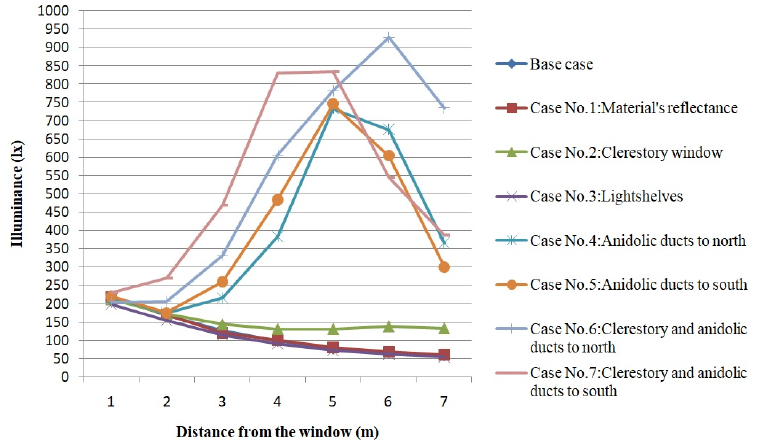
st of June at 12:00 pm.